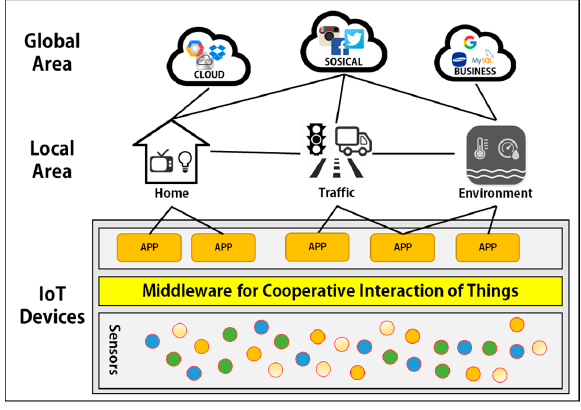
Figure 1. IoT overview based on the proposed middleware.